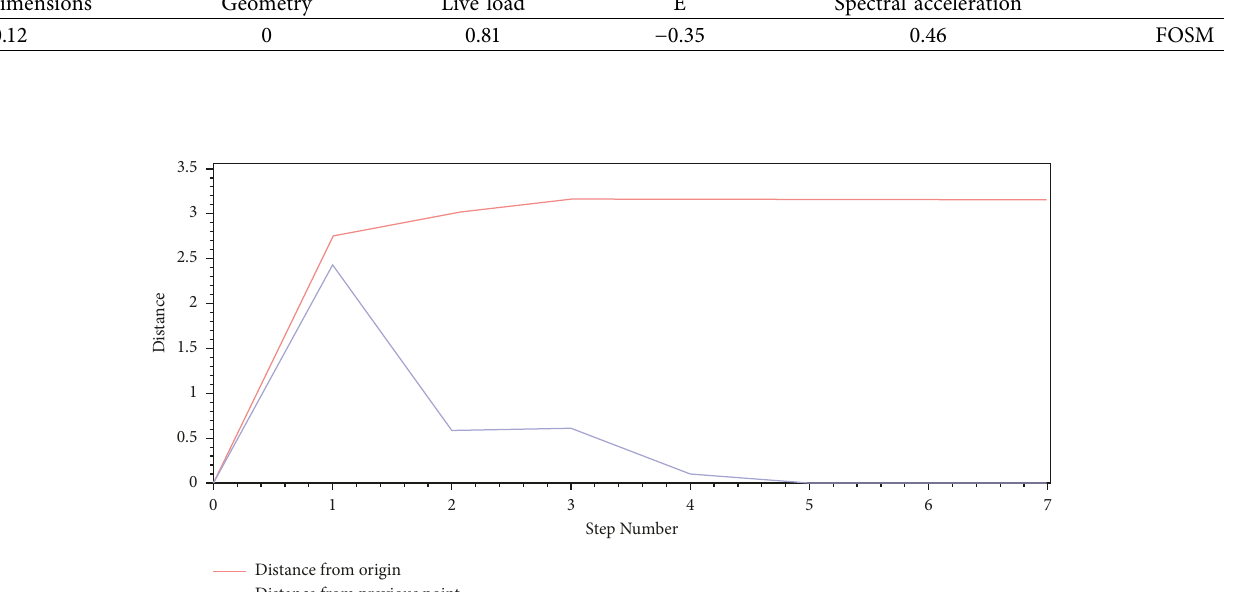
Table 11: Results of the significance scale for uncertainties in FOSM analysis of type V header frames.